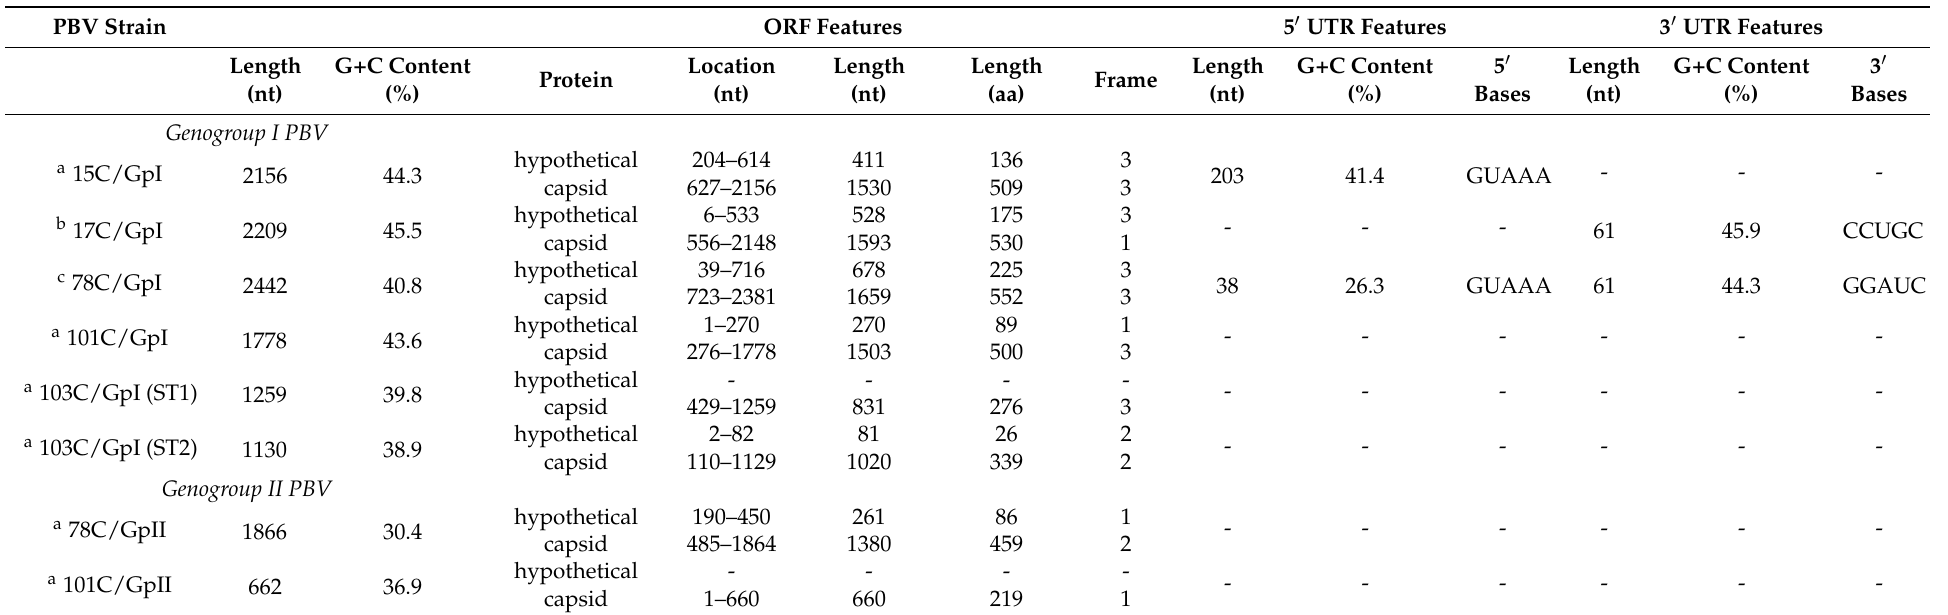
Table 2. Genomic features of segment 1 sequences of genogroup I and genogroup II PBVs from dromedary fecal